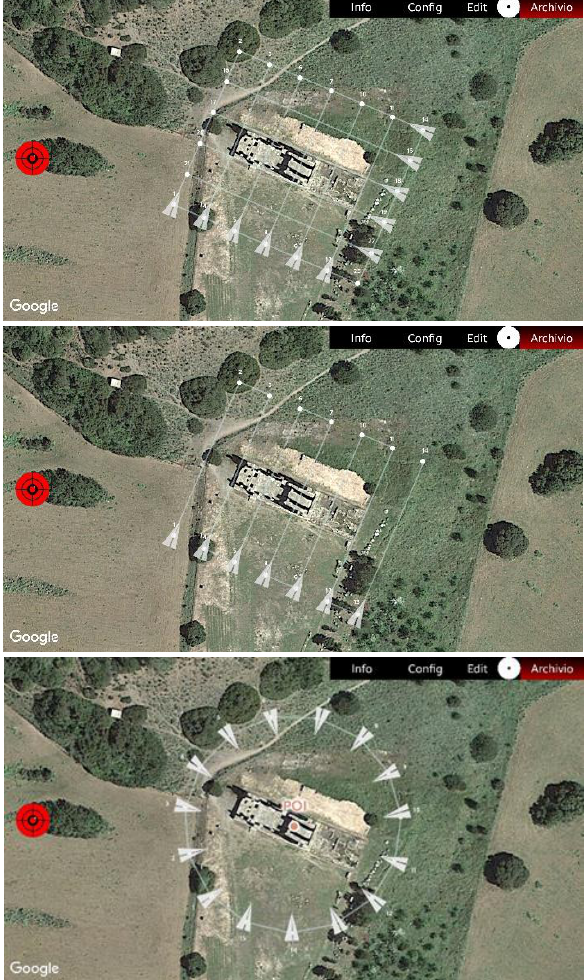
Figure 4. Flight plans with Red Waypoint. Nadir flight (up), oblique-N-S flight (middle) and the oblique-circular one